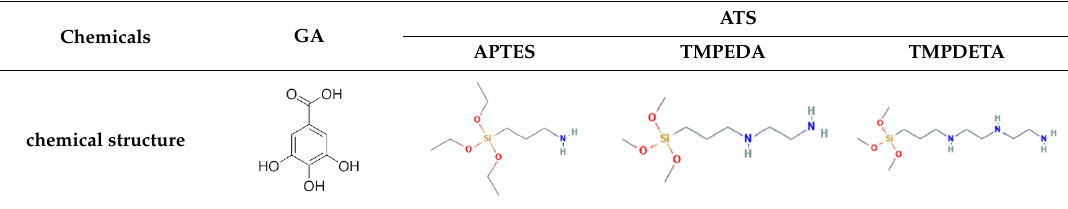
Table2. Chemicalstructuresof3,4,5-trihydroxybenzoicacid(GA),3-aminopropyltriethoxysilane(APTES), N -[3-(trimethoxysilyl)propyl]ethylenediamine(TMPEDA),and(3-trimethoxysilylpropyl)diethylenetriamine Table 2. Chemical structures of 3,4,5-trihydroxybenzoic acid (GA), 3-aminopropyltriethoxysilane (APTES), N -[3-(trimethoxysilyl)propyl]ethylenediamine (TMPEDA), and (3- (TMPDETA).